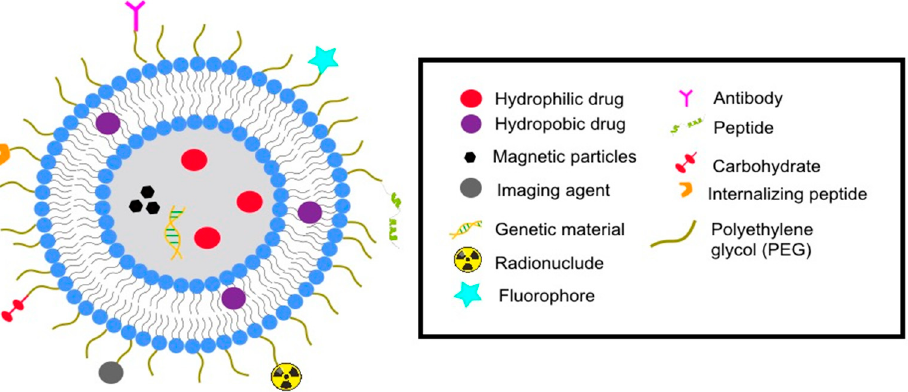
Figure 1. Principal functionalizations of liposomes to establish them as transport systems for drugs.